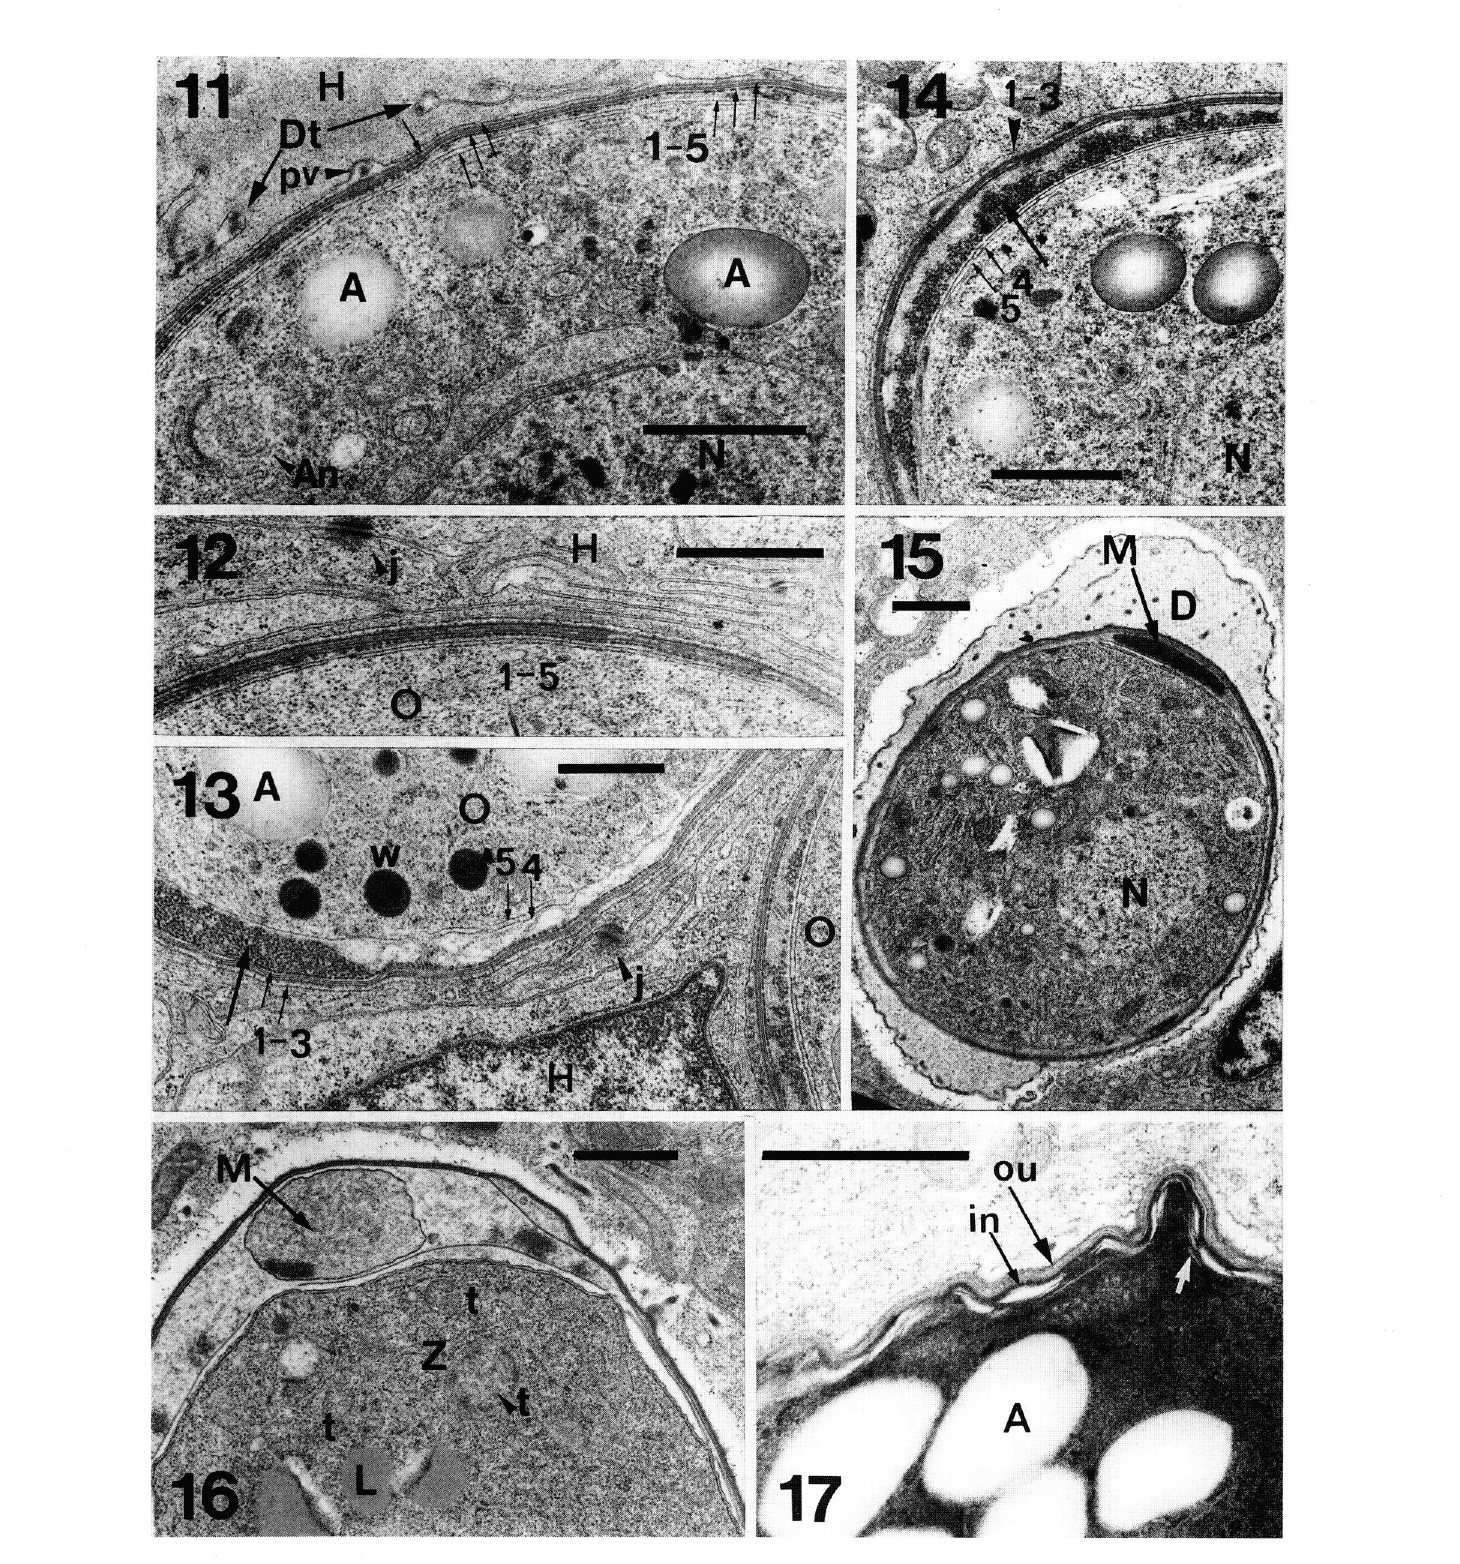
Figs. 11-17. Development from zygote to oocyst. 11. Zygote's wall membrane (1-5) appear, while the PV matrix scatters into the host cell cytoplasm. 12. The walled young oocyst grows against the compressed adjoining epithelial cells showing conspicuous desmosomes. 13 ,14. Further stage in wall formation: wall material accumulates between membranes 3 and 4 (arrow). Note the still present wall-forming-like bodies. 15. Oocyst with microgamete residue, enclosed in matrix-filled PV. 16. Oocyst with microgamete residue - detailed view of the enclosing wall membranes; the PV has disinte grated, and its matrix dispersed. 17. Oocyst encased in a bilayered (ou and in ) hard wall, arrow: inner plasmalemmal bounding mem